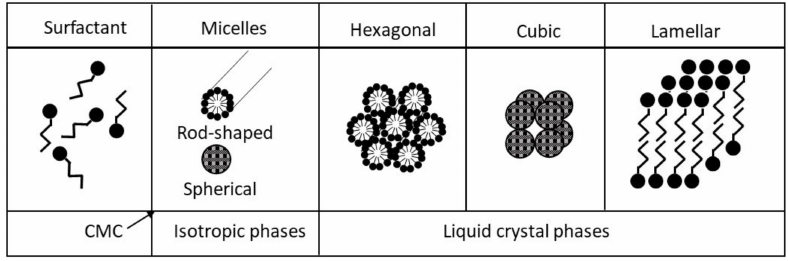
Figure 5. Surfactant phases as a function of its concentration. CMC, critical micelle